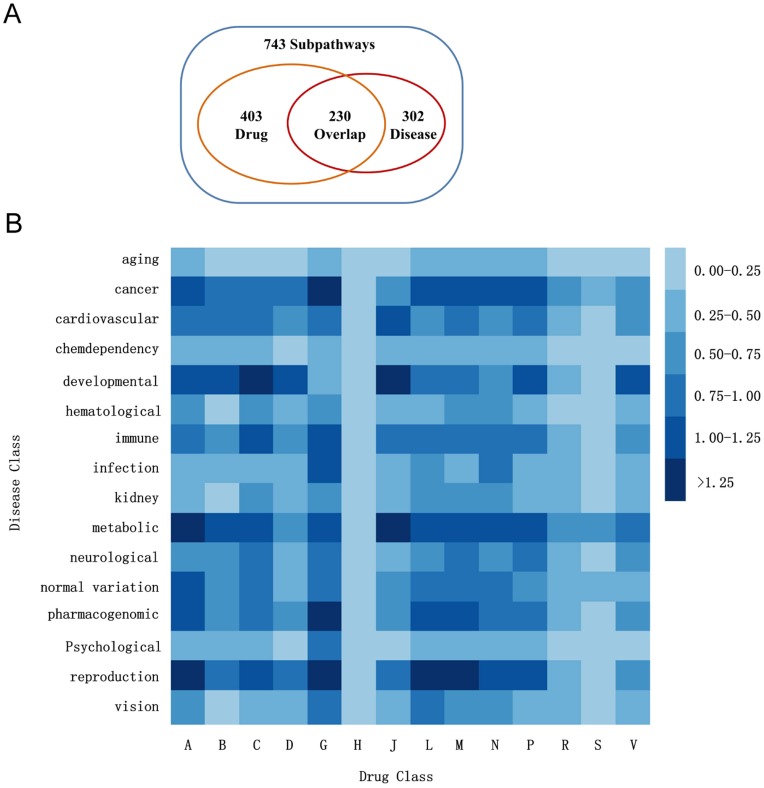
Drug–disease associations through affected metabolic subpathways.(A) There were 743 metabolic subpathways when the setting k = 3. There were 302 disease–related subpathways according to the disease–metabolic subpathways association in the DMSPN and 403 drug-affected subpathways in the DRSN. 230 subpathways were overlapped between the two sets of subpathways. (B) The association scores between each drug class and disease class. The darker color represents the higher association scores.